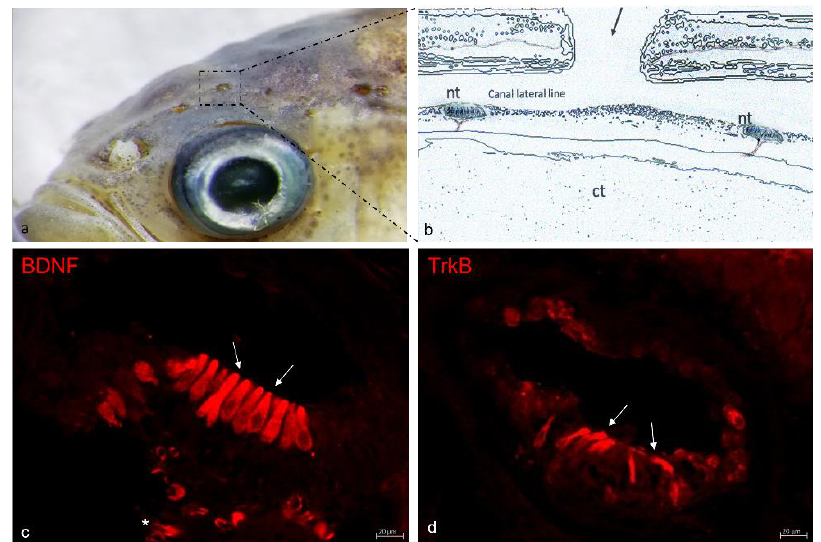
Figure 1. Stereomicrograph of zebrafish head with lateral line system canal pore ( a ). Graphical representation of the canal of the lateral line system; pore (arrow), neuromast (nt) and connettive tissue (ct); ( b ). Immunohistochemical detection of BDNF; ( c ) and TrkB; ( d ) in the sensory hair cells (white arrows) of supra-orbital neuromasts. Magnification 40 × ( c , d